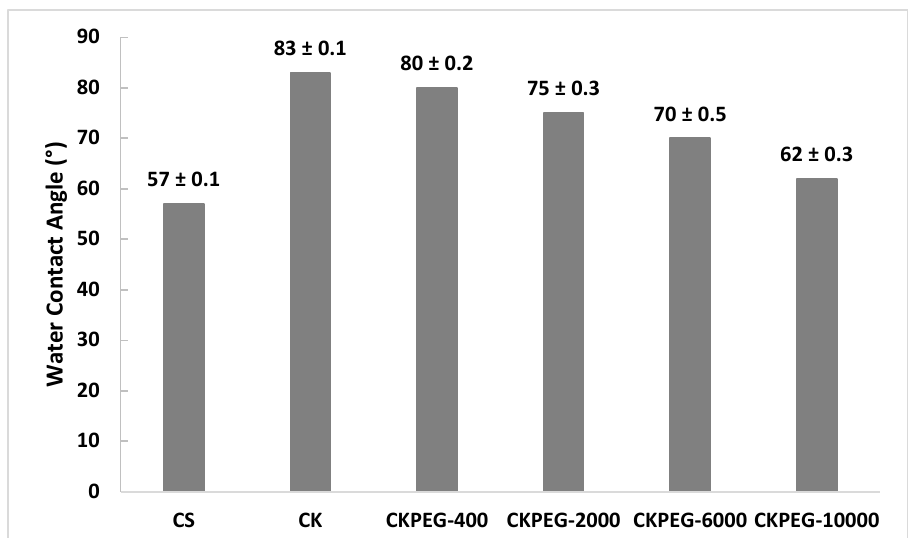
Figure 8. Water contact angles of composite membranes with varying PEG Mw.